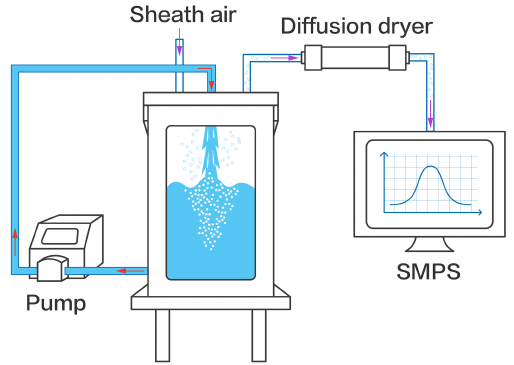
Figure 1. Schematic picture of the plunging jet sea spray aerosol generator. The red arrows represent the flow direction of seawater, and the purple arrows represent the flow of gases and